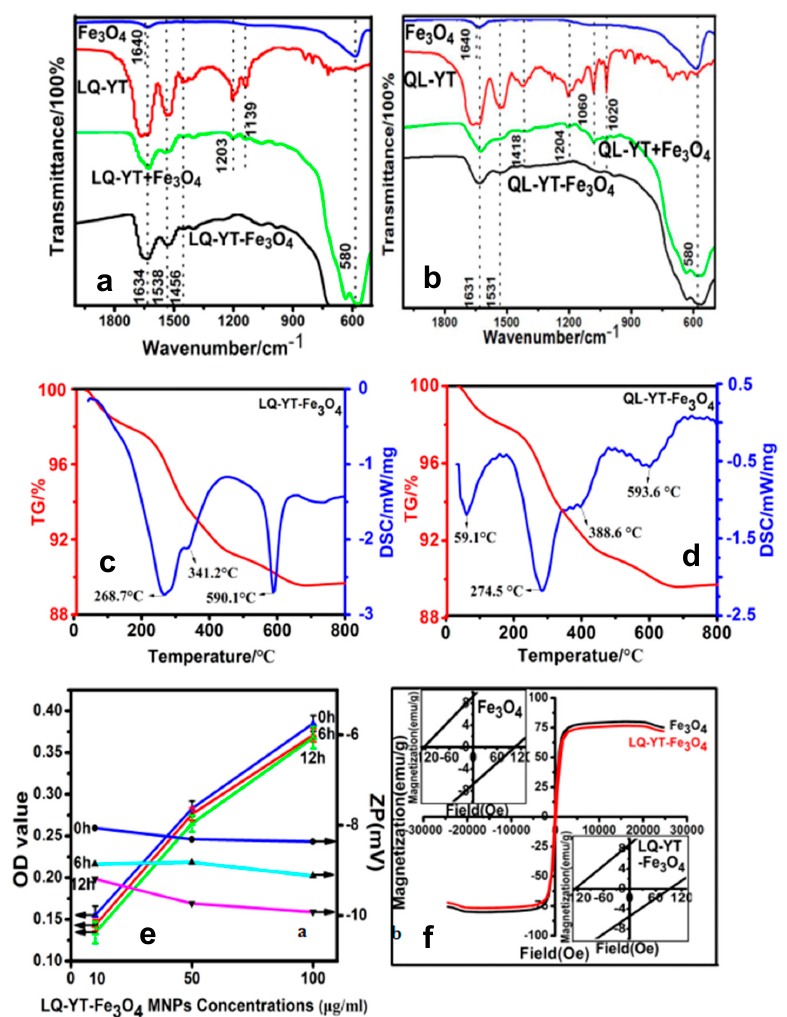
Figure 4. FT-IR spectra curves of ( a ) LQ-YT-modified Fe 3 O 4 -MNPs and ( b ) QL-YT-modified Fe 3 O 4 -MNPs; TG–DSC curves of ( c ) LQ-YT-modified Fe 3 O 4 -MNPs and ( d ) QL-YT-modified Fe 3 O 4 -MNPs; ( e ) serum stabilities curves and ( f ) VSM curves of LQ-YT-modified Fe 3 O 4 -MNPs.